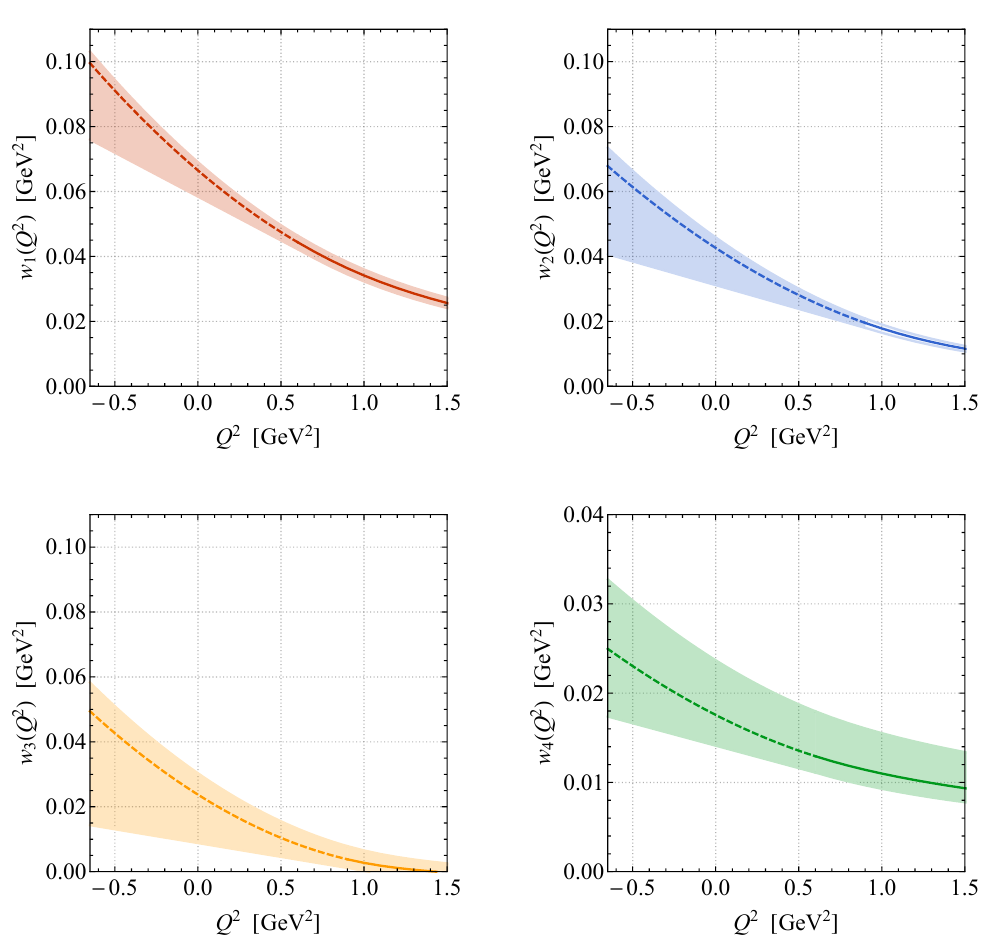
Figure 2 . Form factors w n ( Q 2 ) as a function of Q 2 . The coloured curves and bands correspond to the central values and uncertainties of the LCSRs. In the case of w 1 ( Q 2 ) and w 4 ( Q 2 ) (cid:1) w 3 ( Q 2 ) the predictions for 0 . 6 GeV 2 ≤ Q 2 ≤ 1 . 5 GeV 2 ( 0 . 9 GeV 2 ≤ Q 2 ≤ 1 . 5 GeV 2 ) are obtained by a direct calculation (solid lines), while the predictions for Q 2 ≤ 0 . 6 GeV 2 ( Q 2 ≤ 0 . 9 GeV 2 ) are obtained by an extrapolation (dashed lines). Consult the main text for further